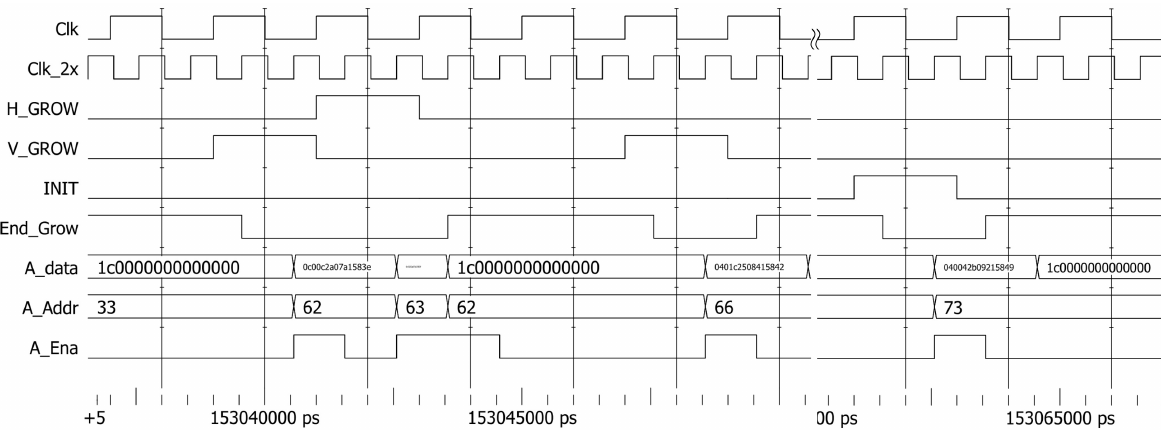
Figure 17. Timing diagram of key signals for area